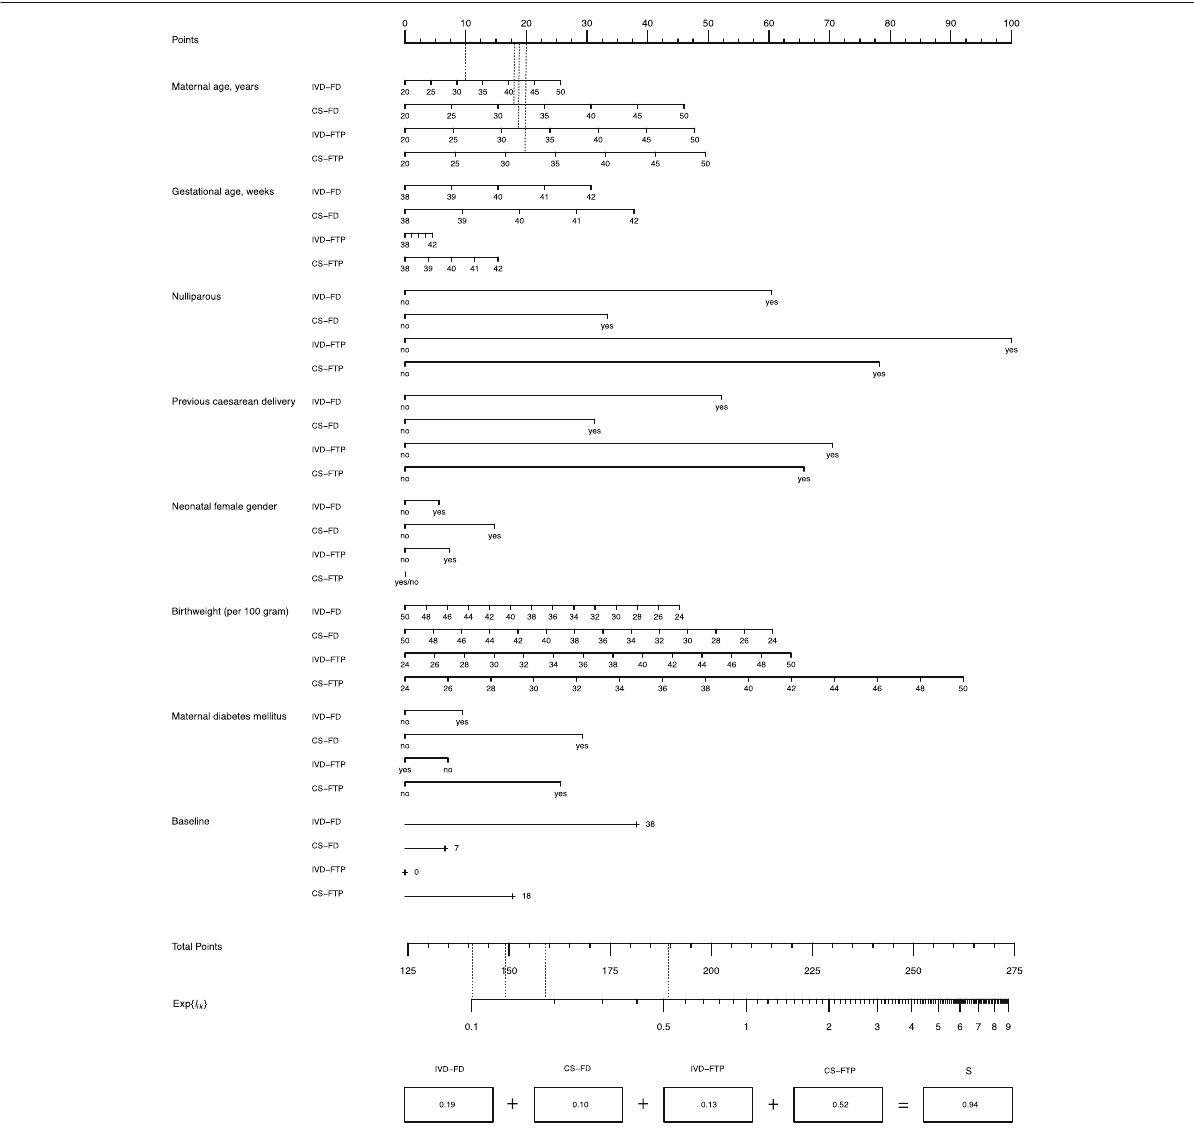
Fig. 2 Scoring chart—hypothetical case study based on multinomial prediction model in Schuit et al. Case description: Maternal age: 32 years; gestational age: 40 weeks; nulliparous; birth weight: 3540 g, maternal diabetes. Abbreviations: instrumental vaginal delivery (IVD), caesarean section (CS), fetal distress (FD), failure to progress